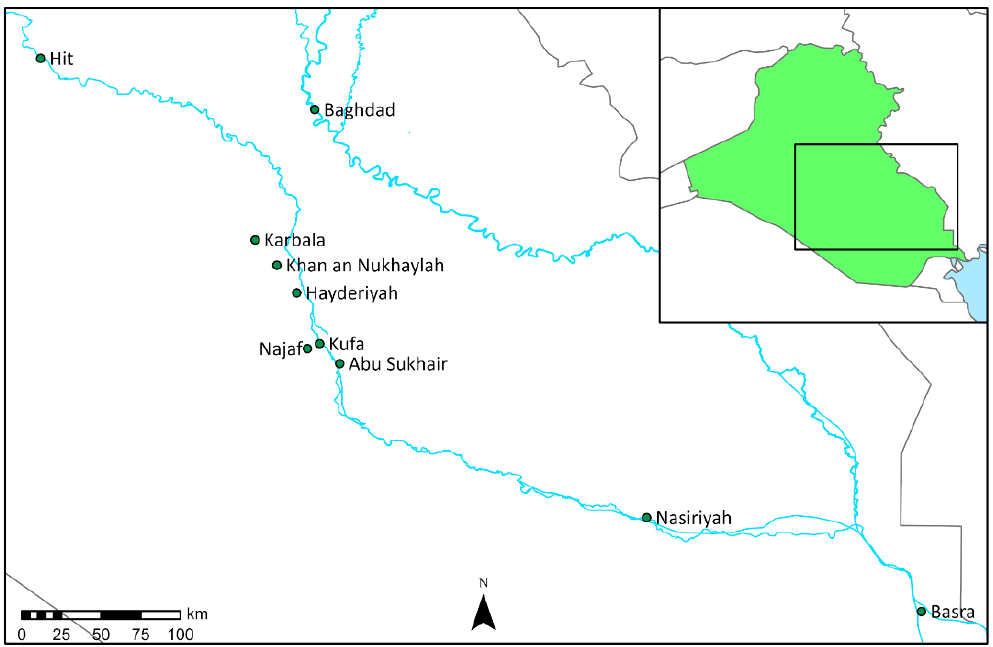
Figure 1. The locations of key sites and cities mentioned in the text.